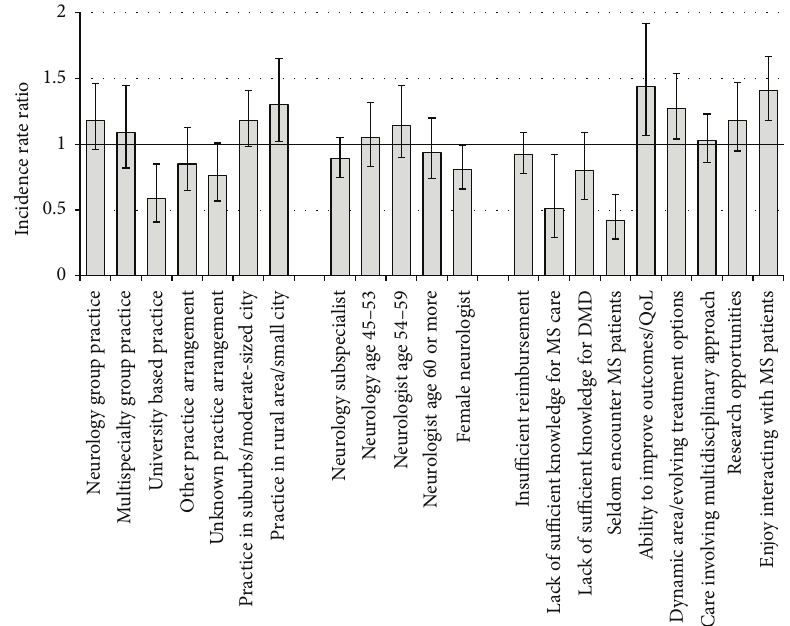
Figure 1: Incidence rate ratios for MS patients seen per week among non-MS subspecialists/general neurologists.